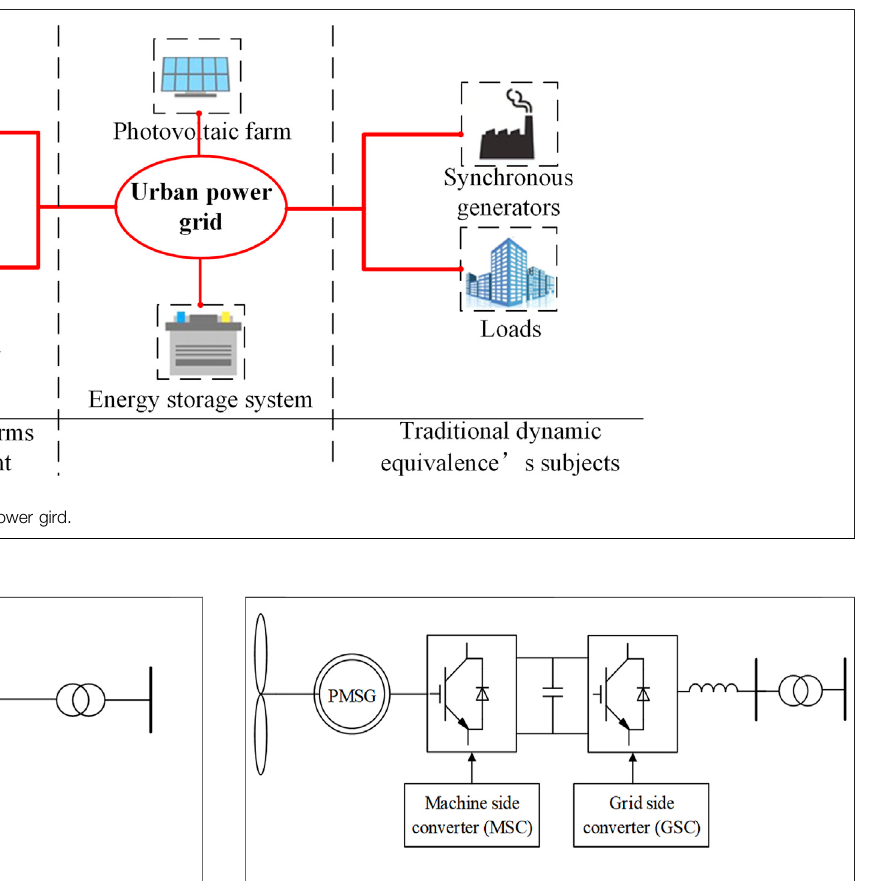
FIGURE 3 | Basic structural diagram of a permanent magnet wind power